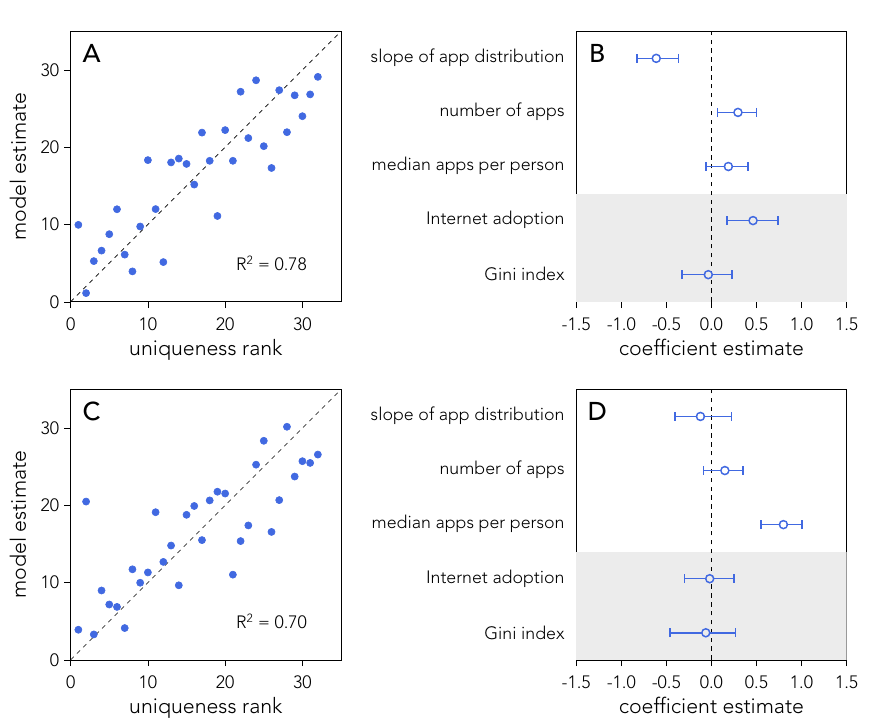
Figure 5. Estimating country uniqueness as function of multiple variables. ( A ) Model predictions using a linear model with rank transformed variables. Uniqueness values are estimated by randomly sampling 5 apps from individuals’ app-fingerprints. ( B ) Coefficient estimates of the model, excluding intercept, including 95% confidence intervals estimated from 10.000 bootstrap samples. The grey shaded area indicates control variables. ( C ) Model predictions for the attack scheme using n = 5 apps. ( D ) Coefficient estimates for the attack scheme model with 95% confidence